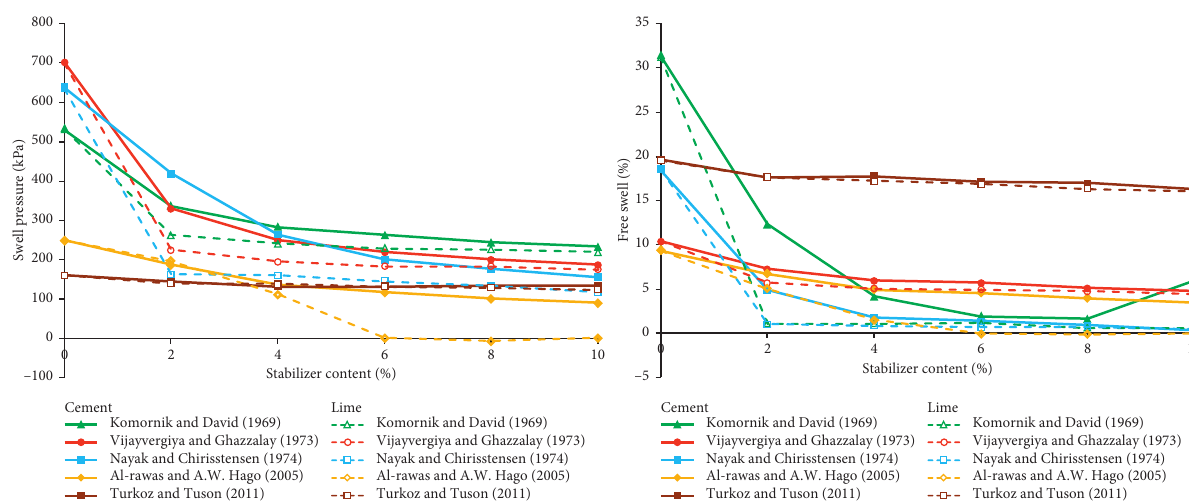
Figure 8: Main effect of both cement and lime on the plot of swelling pressure and free swell, from past